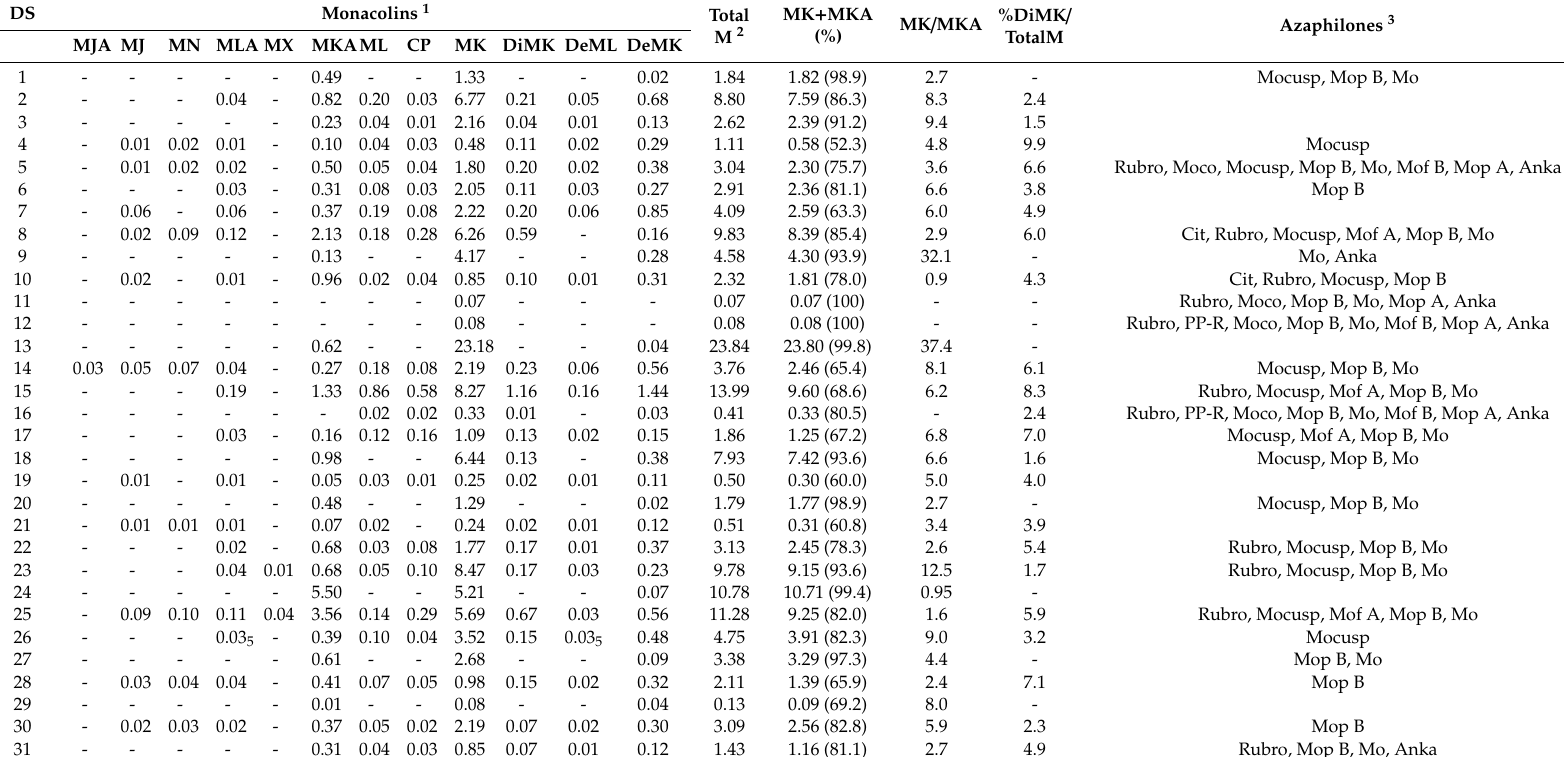
Table 5. Chemical fingerprints of the RYR dietary supplements analyzed by UHPLC and quantitative determination of the monacolins identified (mg per capsule or